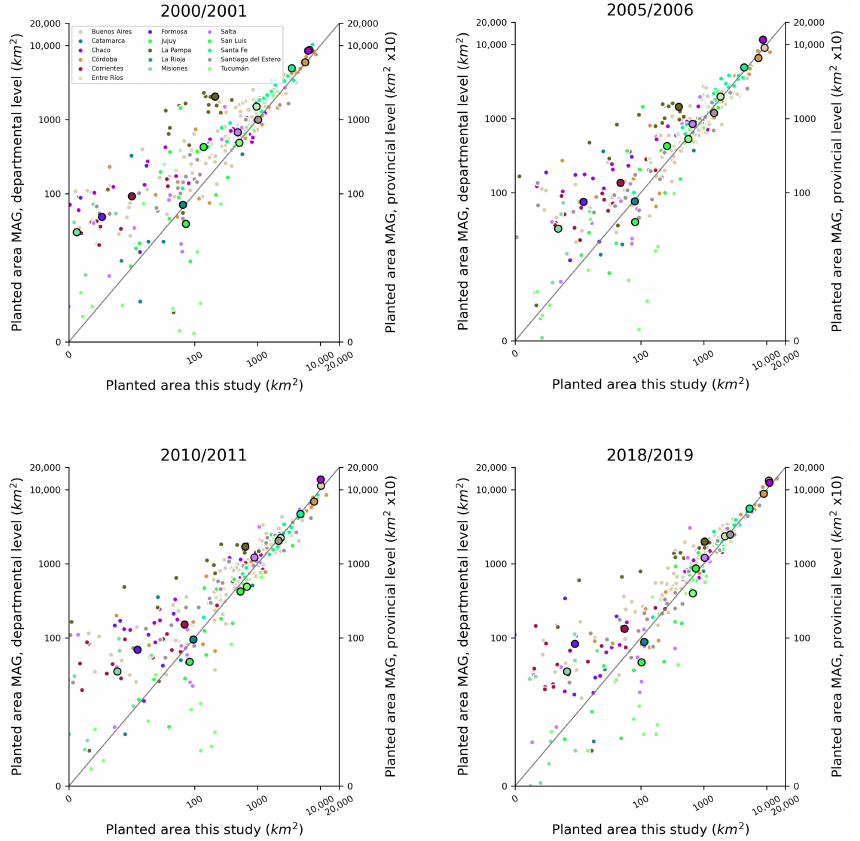
Figure 11. Comparison between planted area estimated in this study ( x -axis) and planted area reported by the Ministerio de Agricultura, Ganadería, and Pesca (MAG) of Argentina ( y -axes) over four time periods: 2000/2001, 2005/2006, 2010/2011, and 2018/2019. The left y -axis shows the total area (km 2 ) of planted cropland for each department (small dots), whereas the right y -axis shows the total area (km 2 × 10) of planted cropland for each province (large dots, outlined in black). The data were logged to better illustrate the cluster of administrative units with low planted area. Colors are unique for each province and provinces not shown here include Chubut and Santa